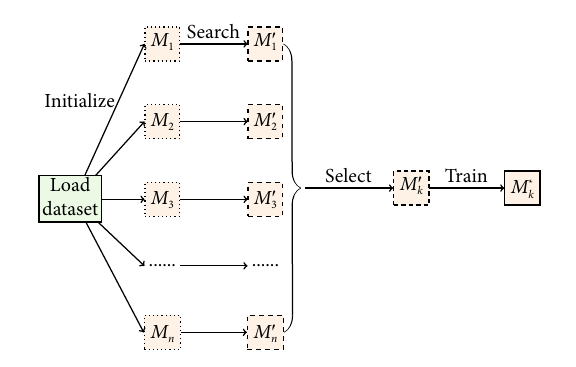
Fig. 5 Overall fitting